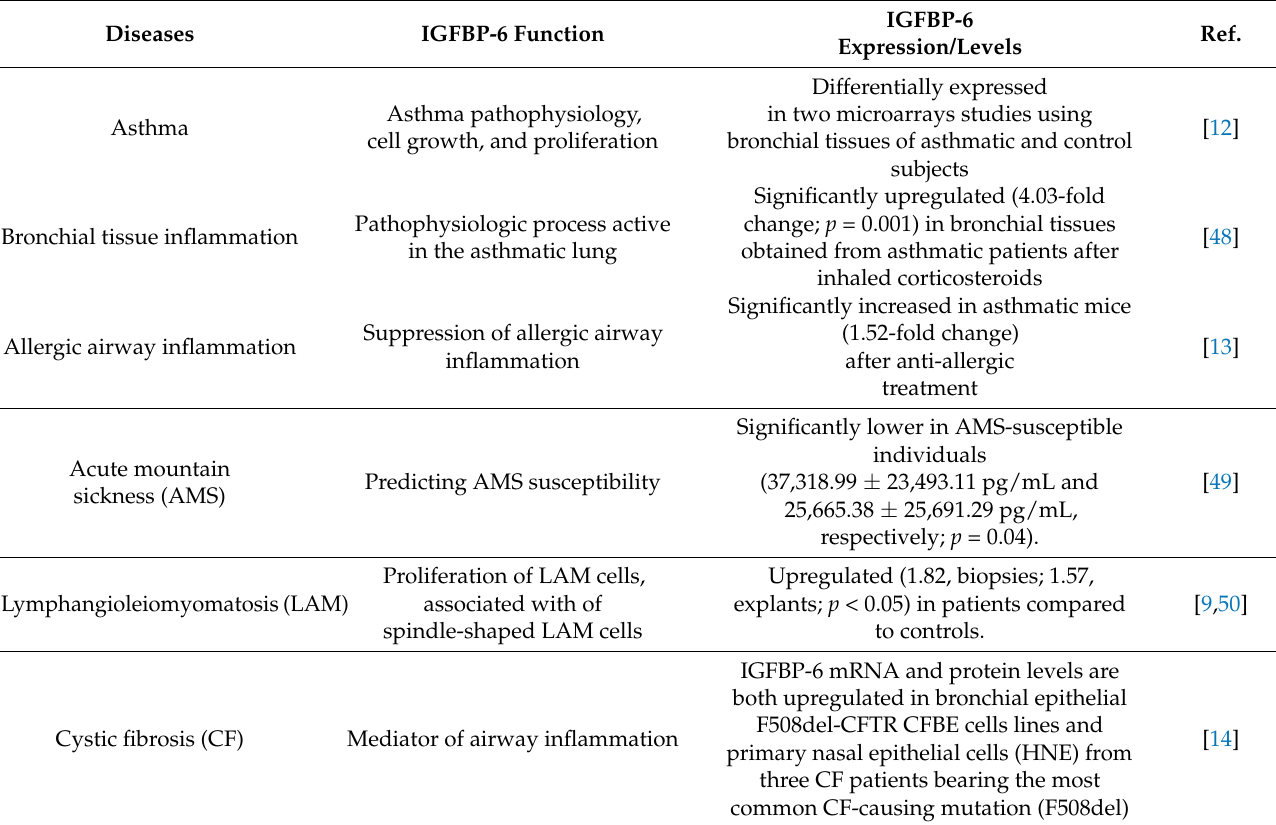
Table 1. IGFBP-6 expression in respiratory